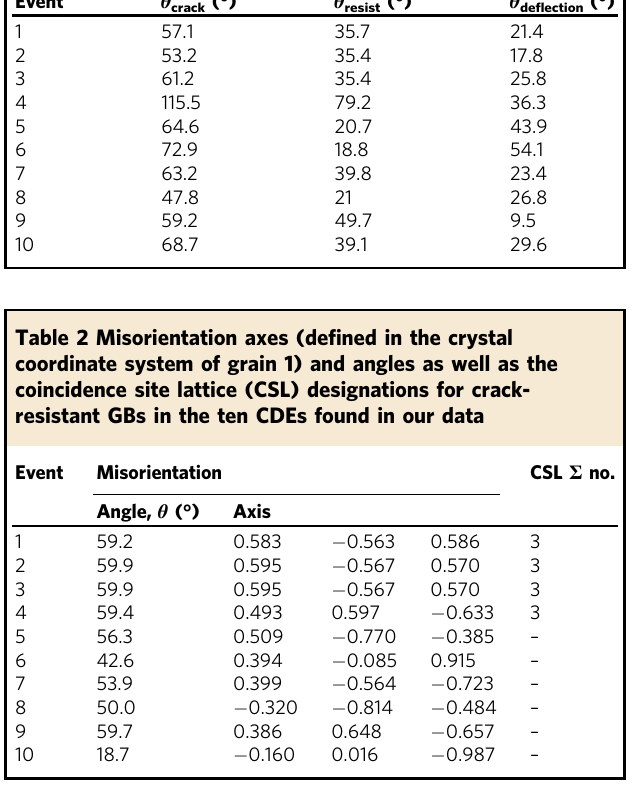
Table 1 Dihedral angles θ crack , θ resist , and θ de fl ection for the ten CDEs identi fi ed in our HEDM/XRAT reconstruction